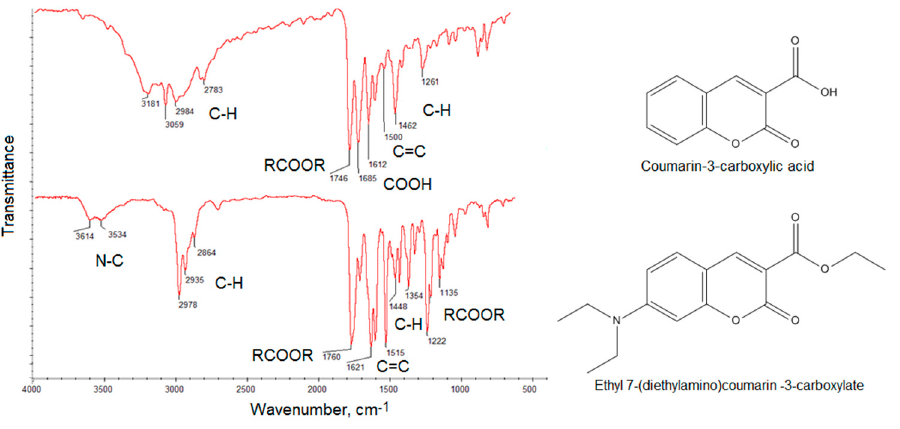
Figure 4. FT-IR spectra of the obtained coumarin derivatives .